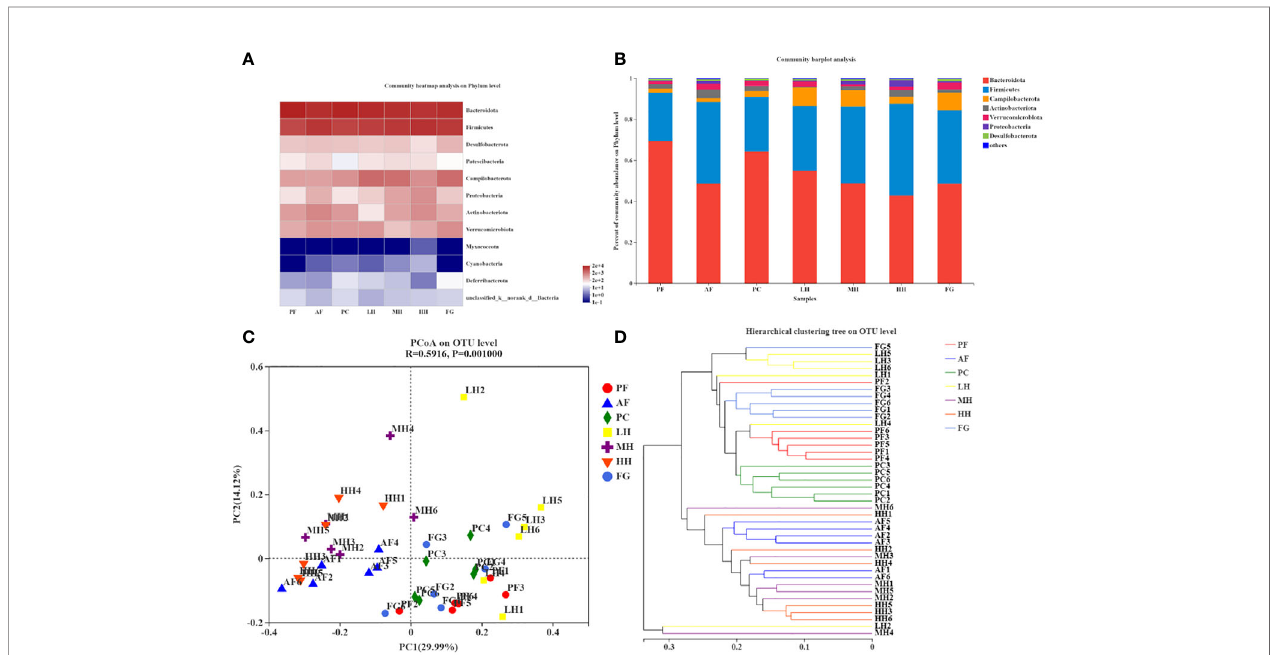
FIGURE 4 | TCH alters gut microbiota structure in mice. Structures of gut microbiota of mice were analyzed using 16S rRNA gene sequencing and bioinformatics analysis. The relative Community heatmap analysis on phylum level (A) . The composition and relative abundances of the gut microbiota at the phylum level (B) . Principal coordinates analysis (PCoA) plots based on unweighted UniFrac (C) . Hierarchical clustering tree on OUT level (D) .